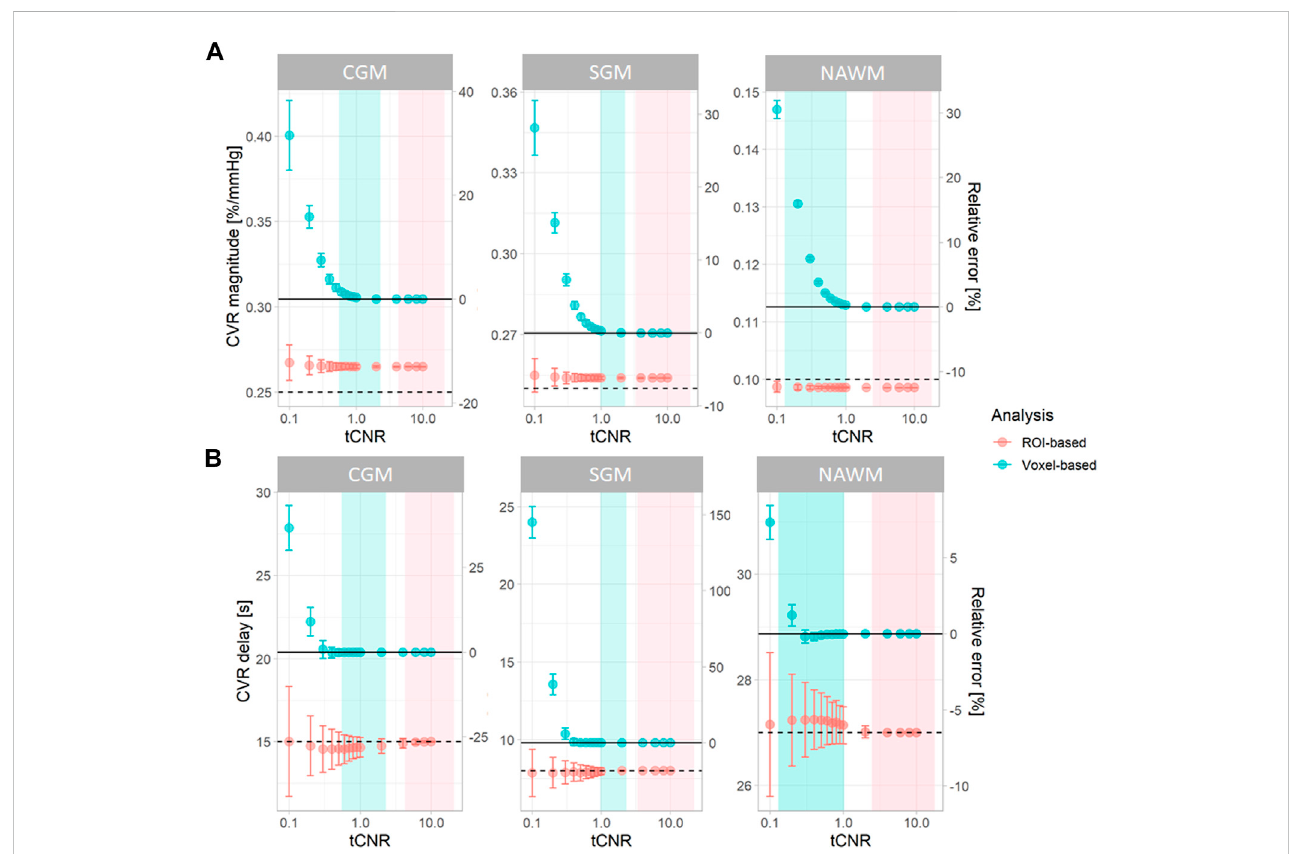
FIGURE 2 Simulations showing the effect of tCNR on the estimation of CVR magnitude (A) and delay (B) corresponding to all subcortical and cortical GM, and NAWMvoxels.Datapointsanderrorbarsindicatethemean±thestandarddeviationoftheestimatesacross1000simulations.Simulationswereperformedfor both ROI- (pink) and voxel-based (blue) analyses. tCNR on the x-axis represents the tCNR in voxels. The ranges of tCNR values in the in vivo data are represented bytheshadedareasinbluefor tCNR invoxelsand inpinkfor tCNR ofmean BOLDsignals. The delayconstraintwasfrom − 31 to93seconds, corresponding to the delay constraint used to process real data. Horizontal solid and dashed lines represent the ground-truth mean and median values, respectively. The relative errors were computed with respect to the ground-truth mean values. (ROI: region of interest, CGM: cortical grey matter, GM: grey matter, NAWM: normal-appearing white matter, SGM: subcortical grey matter, tCNR: temporal contrast-to-noise